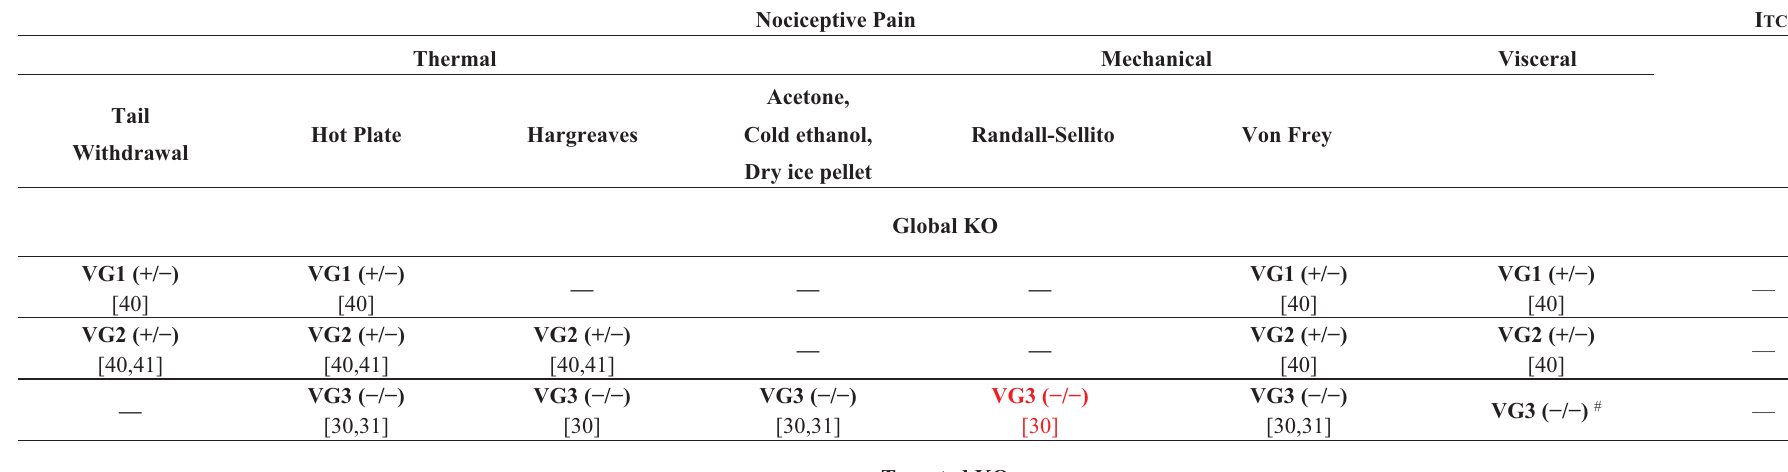
Table 2. Effects on nociceptive pain and itch of various types of VGLUT deletion (Reductions are shown in red, lack of change are shown in black and dashes show pain modalities that have not been assessed; concomitant actions with neuropeptides are shown in purple; # Brumovsky, unpublished data; * Yes, when concomitant pharmacological blockade of